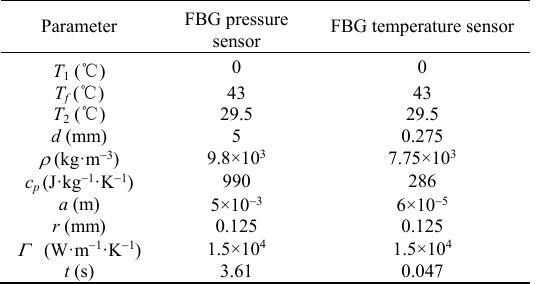
Table 3 Parameters used to determine the response time between the temperature and pressure FBG sensors (5).